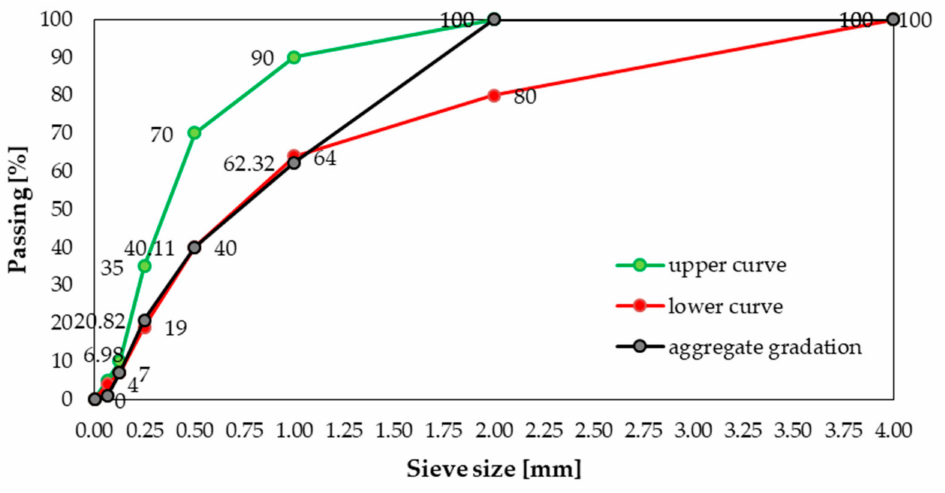
Figure 1. Gradation of crushed granite